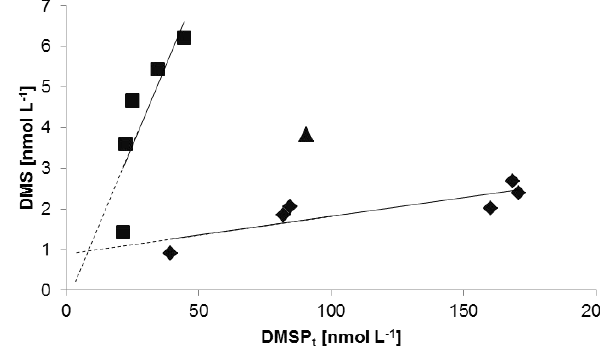
Fig. 7. Binned DMS vs. binned DMSP t : Upper regression line: R 2 = 0 . 69, DMS = 0.158*DMSP t − 0 . 393; lower regression line: R 2 = 0 . 73, DMS = 0.001*DMSP t + 0.893; dashed lines are elonga- tions of the regression lines. The triangle data point is not accounted for by the regression